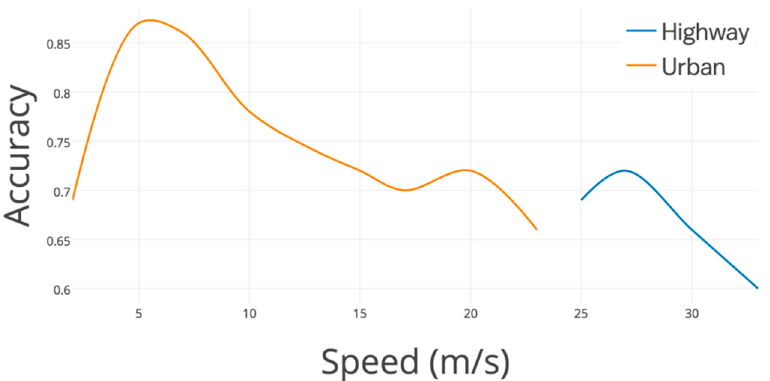
Figure 17. Real-time turning detected accuracy with different speed on urban road and highway.